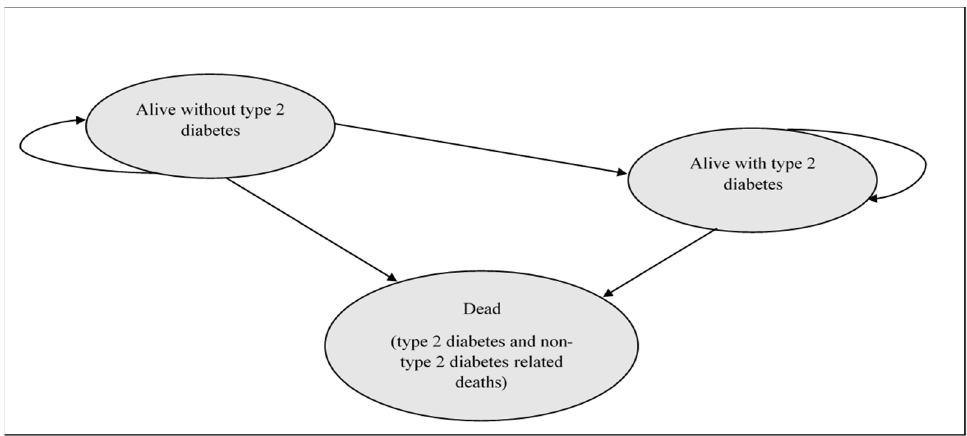
Figure 1. Illustration of the dynamic nature of the model which allows for movement between health states.